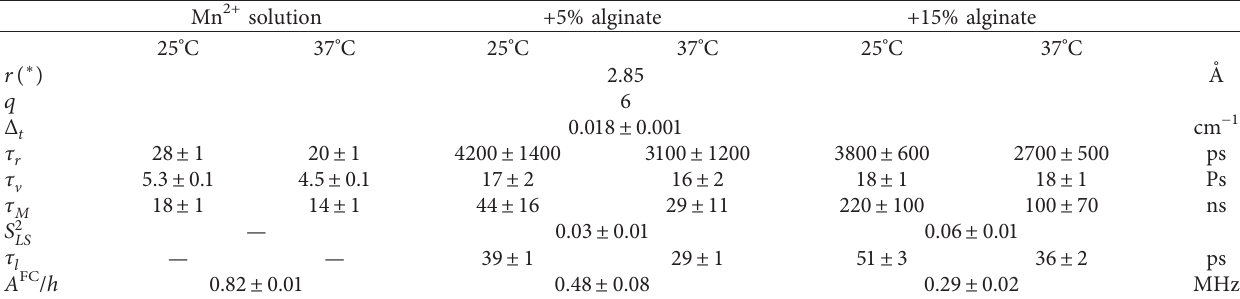
Figure 4: 1 H longitudinal relaxivity profiles (circles) and transverse relaxivity at 400 MHz (stars) of Mn 2+ solutions (pH 3.6) at 25 ° C (solid symbols) and 37 ° C (empty symbols). The solid and dotted lines represent the best fit profiles of the longitudinal and transverse relaxivities, respectively. Table 2: Best fit parameters for Mn 2+ solution without and with addition of alginate 5% or 15%